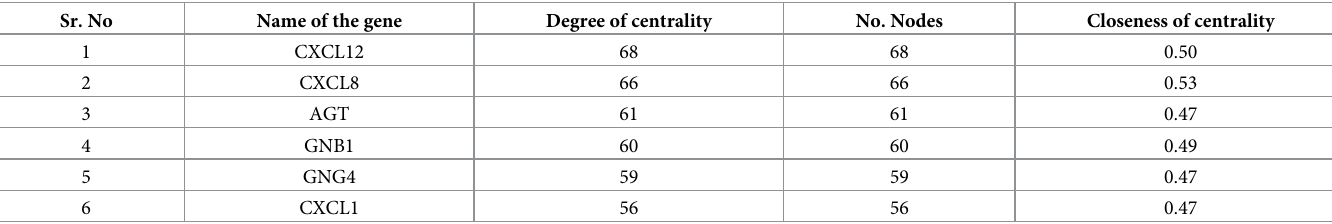
Degree of centrality = It is the number of links incident upon a node. Closeness of centrality = It is a measure of the average shortest distance from one node to other